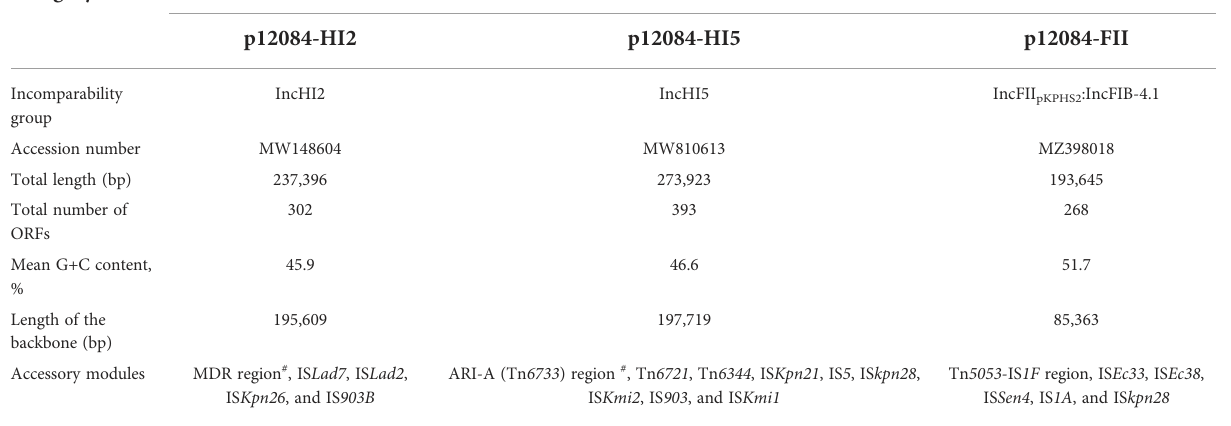
TABLE 2 Major features of three plasmids from strain 12084.